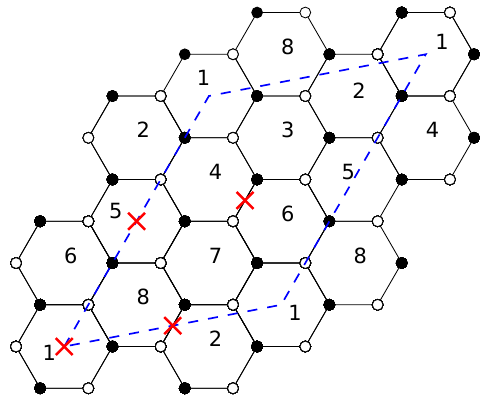
Figure 14 . C 3 = Z